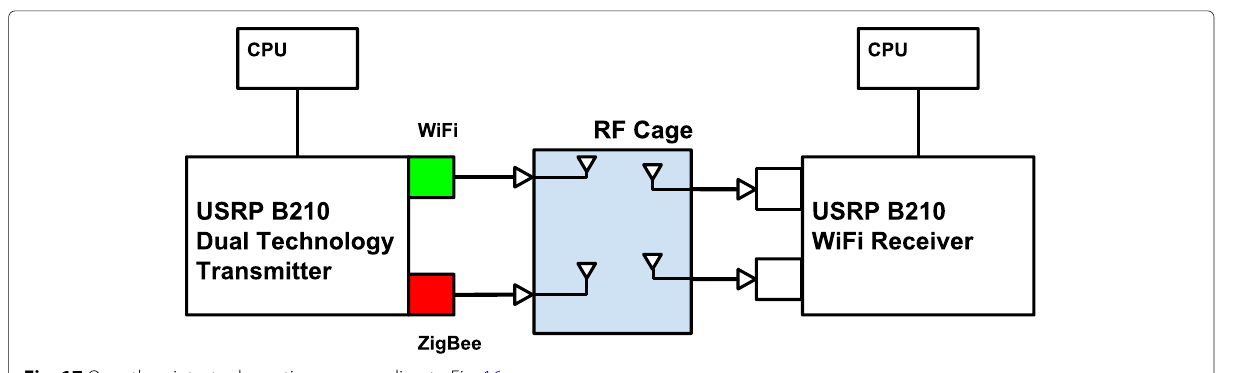
Fig. 17 Over-the-air test schematic corresponding to Fig. 16